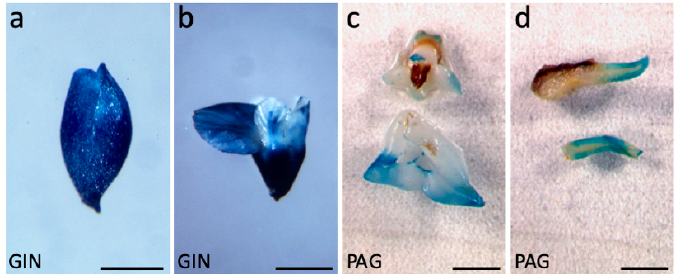
Figure 1. Walnut tree somatic embryo transformation. ( a ) Expression of d35S:: GUS in a transgenic early cotyledonary stage walnut somatic embryo (GIN5 line). ( b ) Expression of d35S:: GUS in a mature GIN1